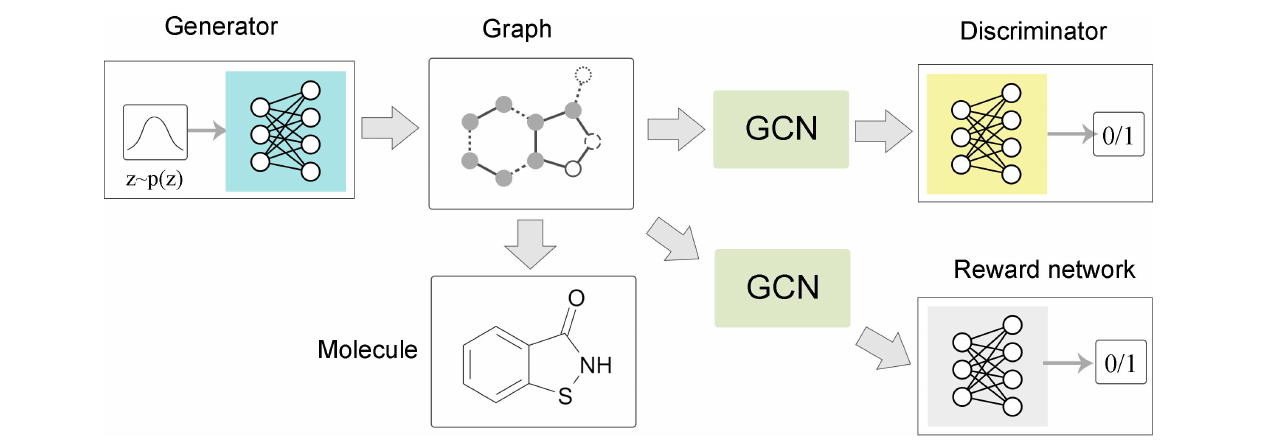
FIGURE 6 | Flow chart of MolGAN. The generator extracted a sample from the prior distribution and generated a molecular graph corresponding to a specific compound. The graph neural network-based discriminator and reward network directly operate on the representation of the graph structure. The discriminator learns to distinguish whether the molecular graph comes from the real data set or the generator. The reward network assigned rewards to each molecular graph based on samples and optimized the generation process through reinforcement learning methods.